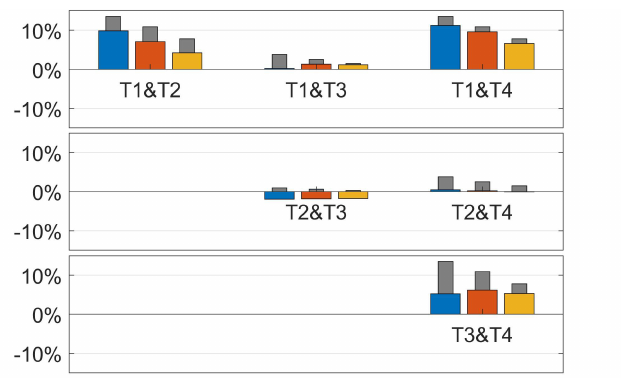
Figure 4. Relative power gain by AWC when 2 out of the 4 wind turbines in a row are not